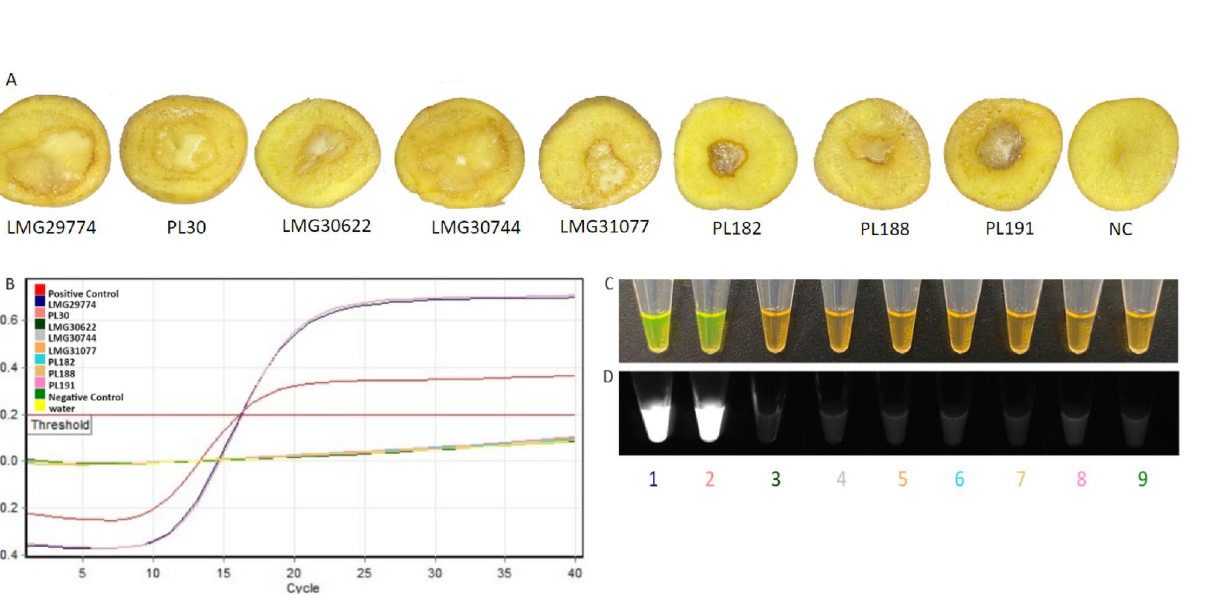
Figure 6. Detection of Pectobacterium parmentieri from infected potato samples. ( A ) Infected potato slices infected with different Pectobacterium species and Dickeya dianthicola; LMG29774 P. parmentieri , PL30 P. parmentieri , LMG30622 P. punjabense , LMG30744 P. fontis , LMG31077 P. polonicum , PL182 P. carotovorum , PL188 P. wasabiae , PL191 D. dianthicola , NC (negative control) healthy potato. ( B ) Standard curve diagram– only two P. parmentieri infected potato slices and positive control LMG29774 P. parmentieri were positive, no curve was observed with NC (negative control) healthy potato and NTC, non-template control (water). ( C ) Visualization of LAMP products after addition of SYBR Green I dye—green color represents positive amplification. ( D ) Visualization of SYBR Green I results under UV light—fluorescence indicative of positive amplification. 1, LMG29774 P. parmentieri; 2, PL30 P. parmentieri; 3, LMG30622 P . punjabense ; 4, LMG30744 P. fontis ; 5, LMG31077 P. polonicum ; 6, PL182 P. carotovorum ; 7, PL188 P. wasabiae ; 8, PL191 D. dianthicola ; 9, NC healthy